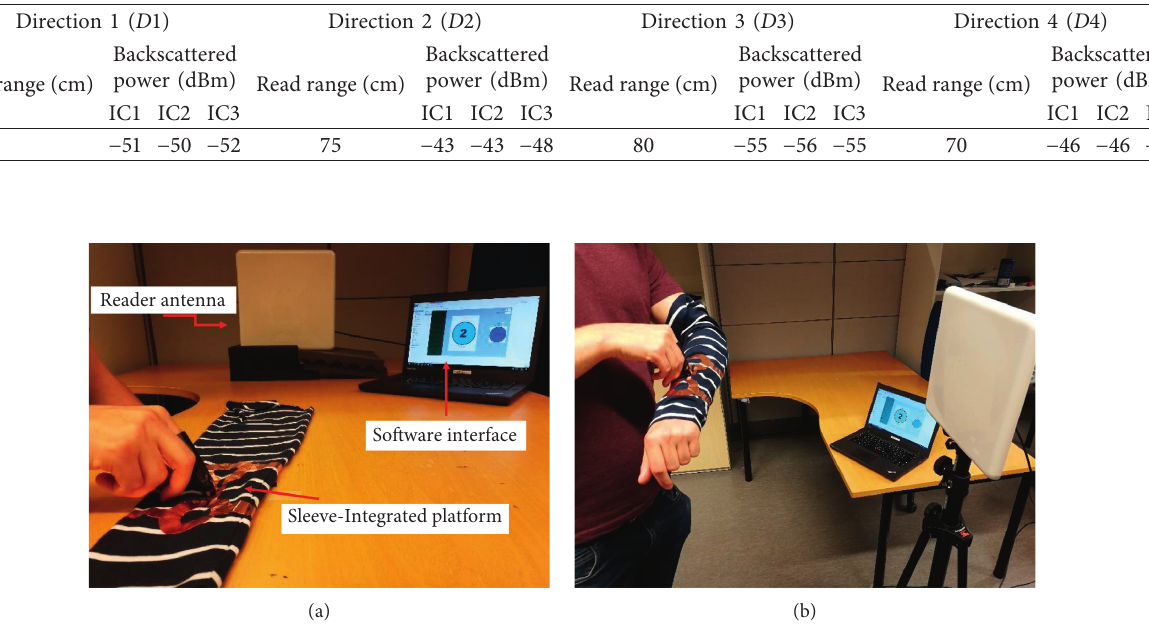
Figure 3: (a) Platform testing with a mobile reader and (b) M6 reader. Table 1: Preliminary testing results with the M6 RFID reader.